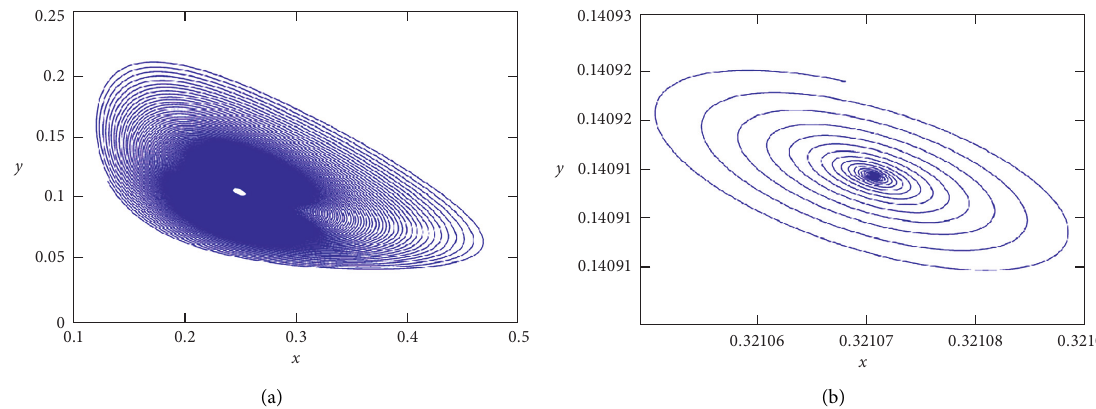
Figure 2: Phase portraits of the autonomous system for parameter values corresponding to Hopf bifurcation at fixed point E α H ′ � 0 . 00845; β � 0 . 01 and (b): α H ′ � 0 . 0237; β � 0 .